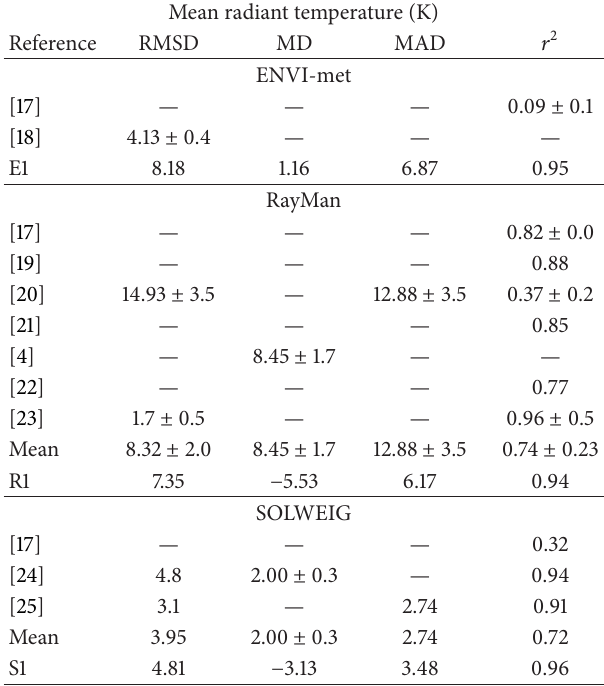
Table 9: Overview of deviations in mean radiant temperature between simulations and observations in other studies concerning root-mean-square deviation (RMSD), mean deviation (MD), mean absolute deviation (MAD), and coefficient of determination ( 𝑟 2 ). Standard deviations ( ± ) are stated, if more than one analysis is performed per